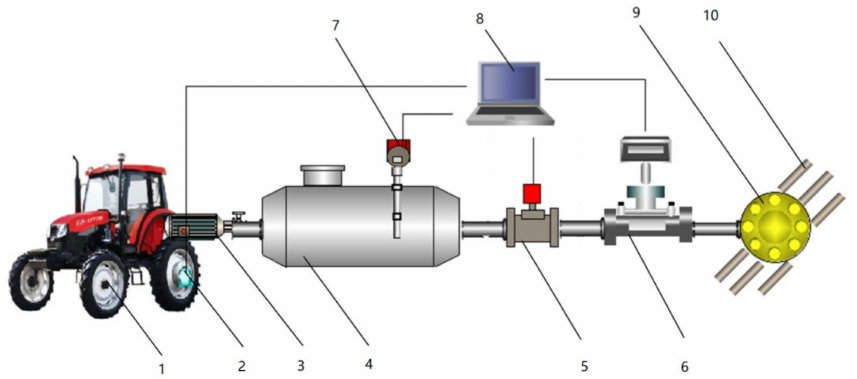
Figure 1. Structure diagram of fertilizer throwing control device: 1: tractor; 2: angular speed sensor;